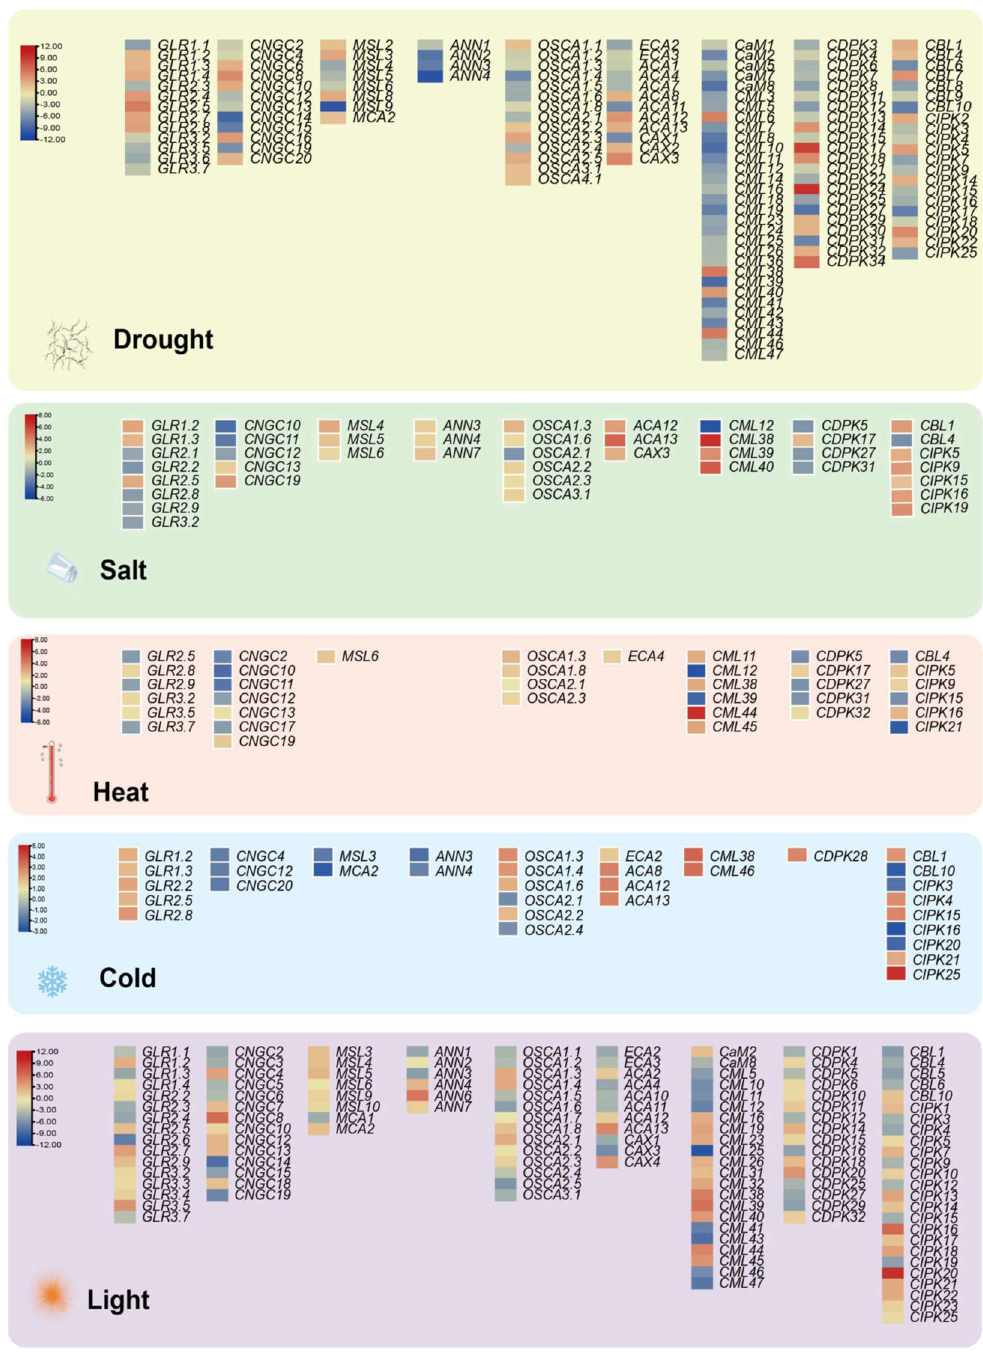
Figure 5. DEGs-based integrated expression profiles of Ca 2+ singling genes in drought, salt, heat, cold and light. DEGs are filtered in the Expression Atlas databases with the following setting parameters: adjusted p -value < 0.001, |log 2[fold change] | > 1. Red, up-regulated; Yellow, non-changed; Blue, down-regulated. The scale of the different stress modules also slightly varies.